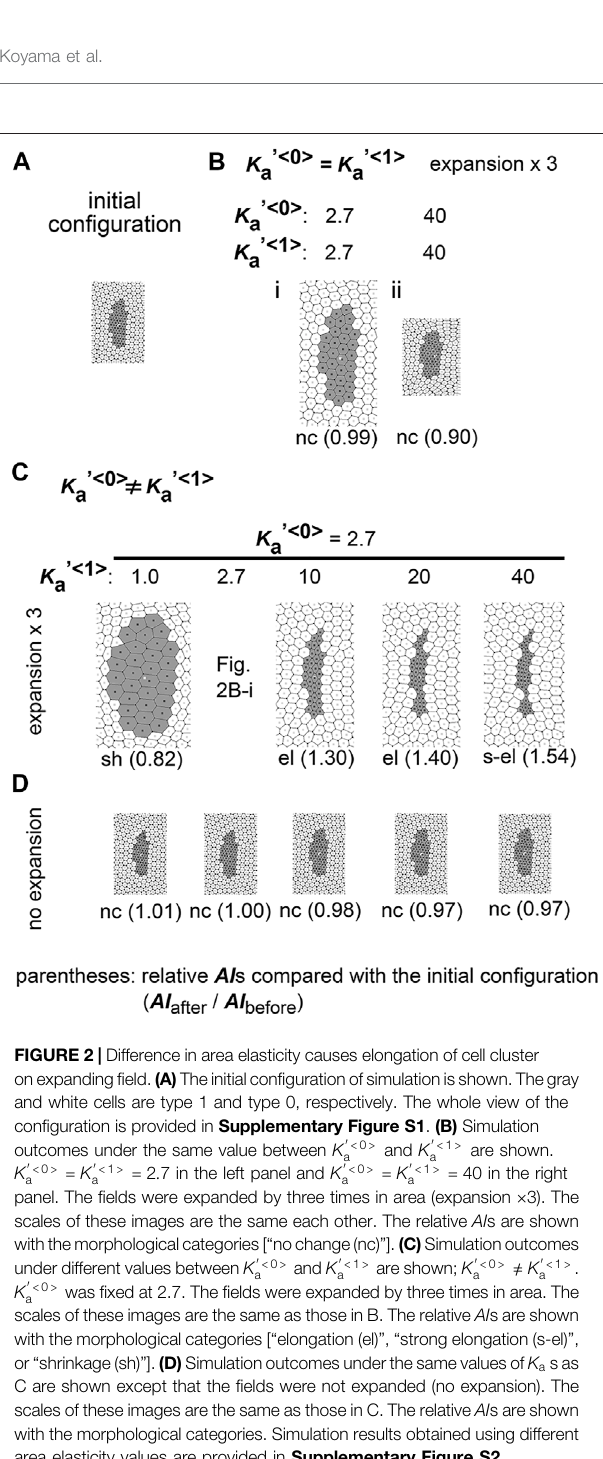
Frontiers in Cell and Developmental Biology |